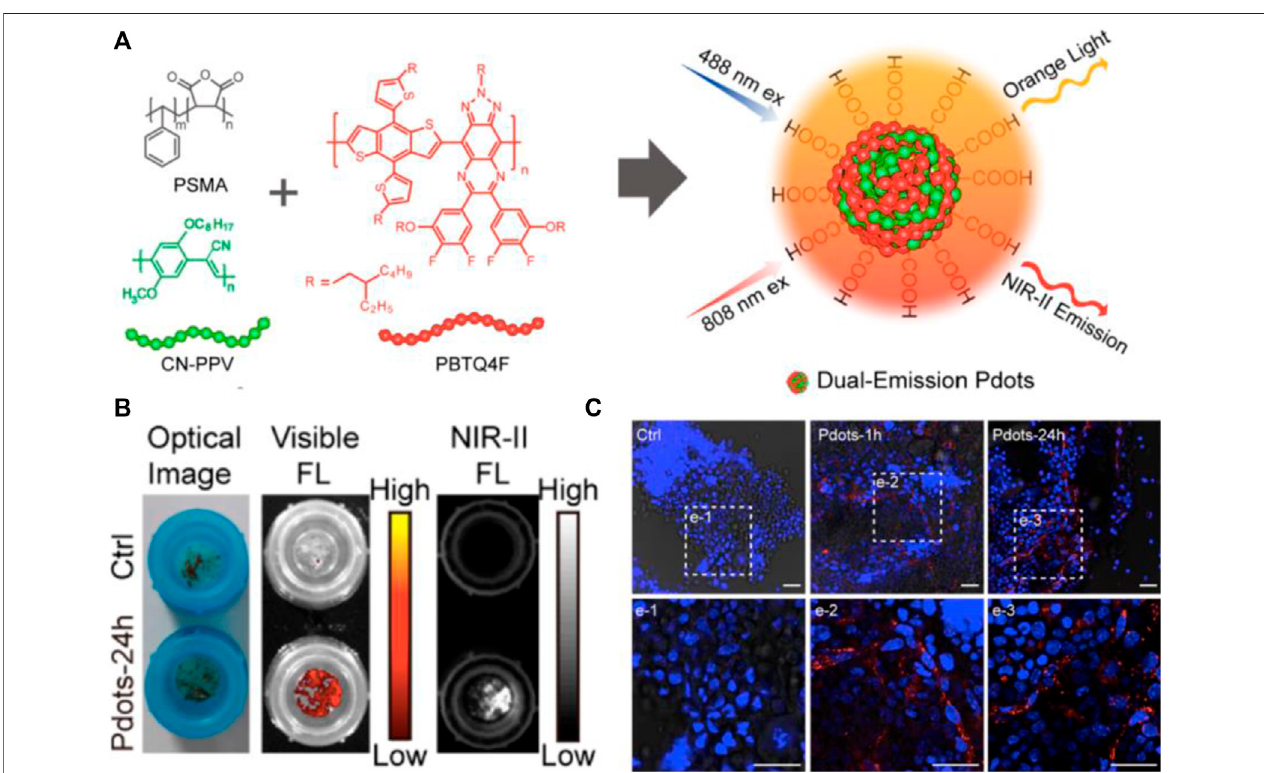
FIGURE 2 | NIR-II fl uorescence imaging reveals bone marrow retention using dual-emission polymer dots (Pdots). (A) Schematic illustration for the preparation of dual-emissionPdots. (B) Opticalphotographand fl uorescenceimagingofbonemarrowretainedbyacellstrainer. (C) Confocalimagesofbonemarrowcellsretainedby a cell strainer. Scale bar: 25 μ m. Reproduced with permission from Chen et al. (2021).